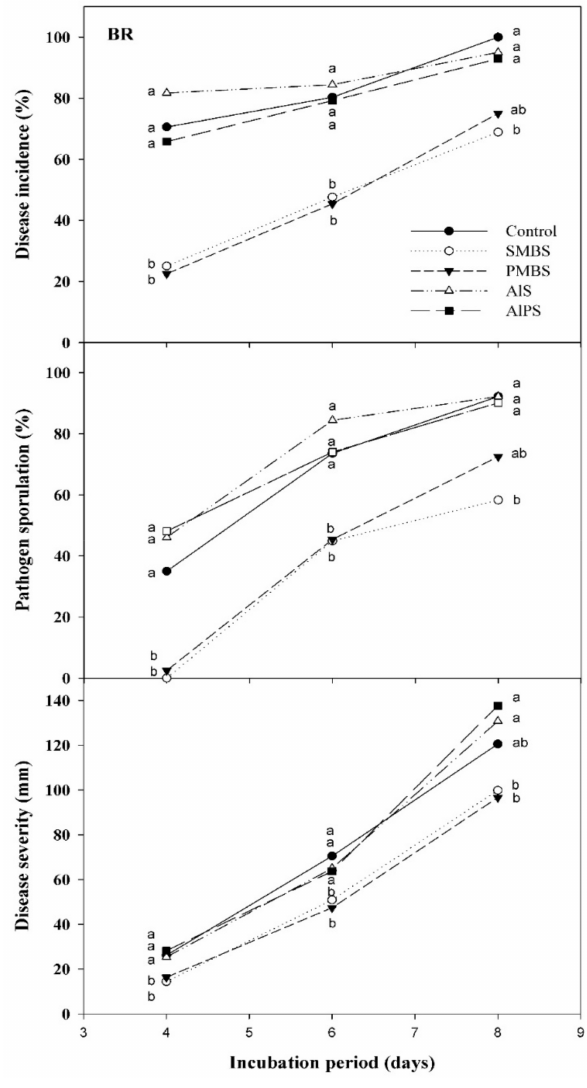
Figure 3. Curative activity of 1 min dips at 20 ◦ C in water (control) or aqueous solutions of sodium metabisulfite (SMBS), potassium metabisulfite (PMBS), aluminum sulfate (AlS), and aluminum potassium sulfate (AlPS) at 10 mM to control brown rot (BR) on ‘Ambra’ nectarines artificially inoculated with Monilinia fructicola , dipped 24 h later, and incubated for up to 8 days at 20 ◦ C. Disease incidence and severity and pathogen sporulation are presented. For each dependent variable and evaluation date, means with different letters are significantly different according to Fisher’s protected LSD test ( p < 0.05) applied after an ANOVA. Represented values are means from two repeated experiments. Incidence and sporulation values were arcsine-transformed. Non-transformed means are